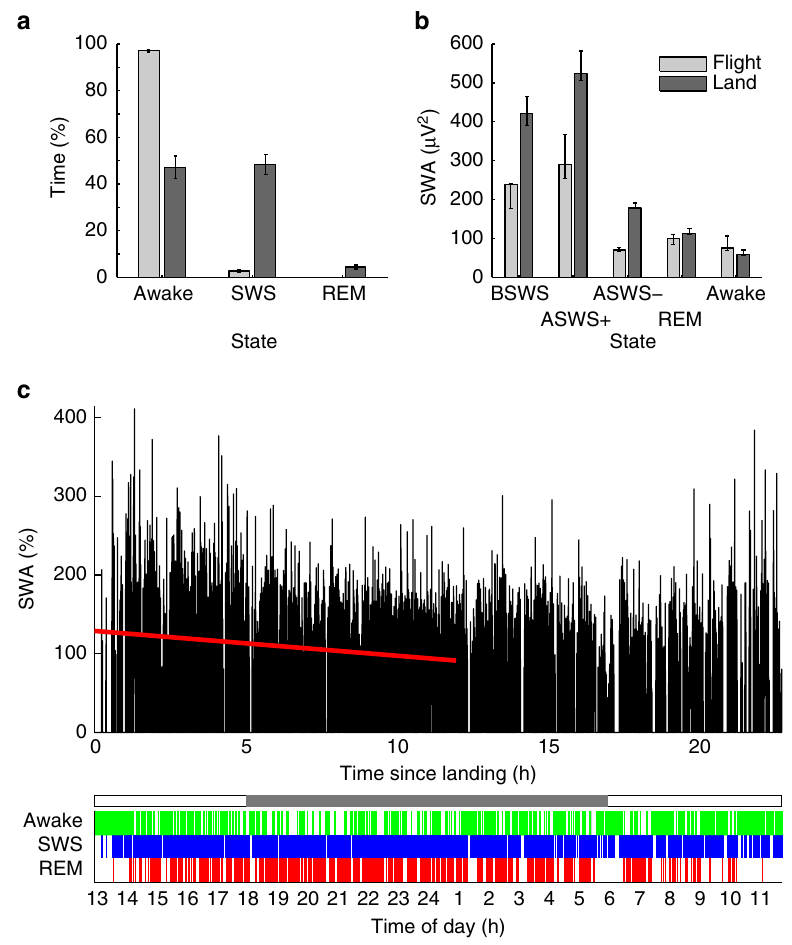
Figure 4 | Frigatebirds sleep more and deeper on land than in flight. ( a ) Time spent awake and in SWS and REM sleep in flight and on land. ( b ) Electroencephalogram (EEG) slow wave activity (SWA; 0.75–4.5Hz power) while awake and in SWS and REM sleep in flight and on land (median and quartiles for the median). For SWS, SWA is shown for, (1) bihemispheric SWS (BSWS), (2) asymmetric SWS (ASWS) for the hemisphere with greater SWA (ASWS þ ) and (3) ASWS for the hemisphere with lower SWA (ASWS–). ( c ) Decline in SWS-related SWA during the first 12h since landing (top) and the corresponding sleep staging (bottom) in one bird; awake (green), SWS (blue), and REM sleep (red). In the photoperiod bar (middle) grey reflects